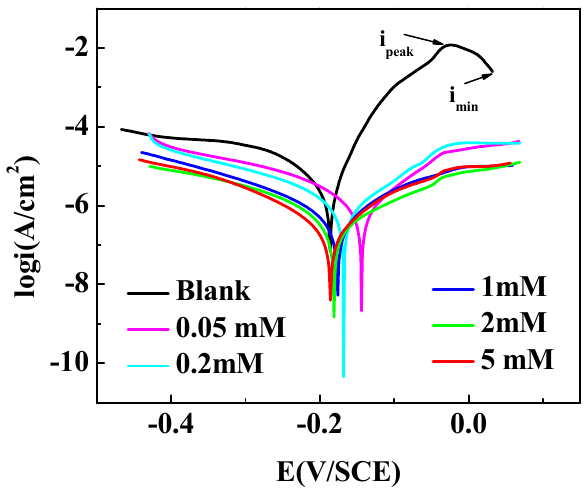
Figure 4. Polarization curves for copper with and without different concentrations of MTT in 3% NaCl at 298 K. Table 2. The relevant parameters from polarization curve measurement.